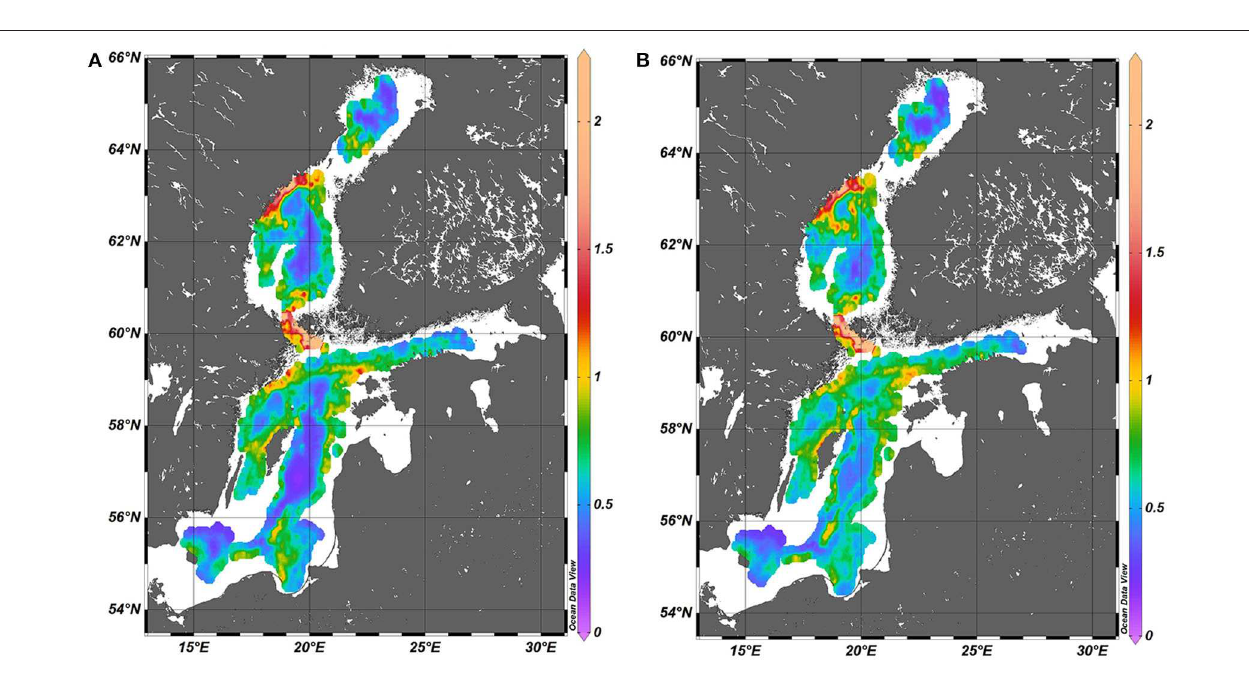
FIGURE 7 | Spatial distribution of the spectral amplitude (Equation 4) of vertical fluctuations of the main pycnocline (m) in 1961–1965 (A) and 2000–2005 (B) . The maximum value is 4.5 but for better readability the scale is limited to